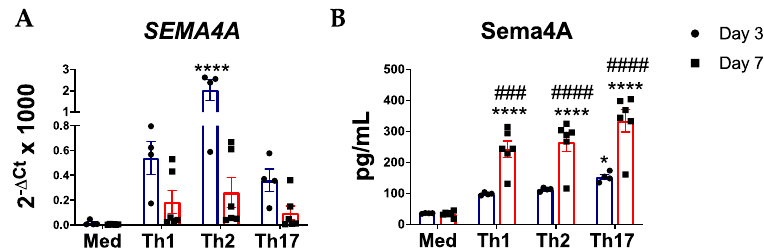
Figure 1. Sema4A is induced during T helper cell differentiation. Sema4A mRNA ( A ) and protein ( B ) levels in unstimulated naïve CD4 + T cells or in Th1, Th2 or Th17 differentiated cells for 3 days ( n = 4) and 7 days ( n = 6). Means and SEM are shown. * p < 0.05 and **** p < 0.0001 compared to the medium at day 3. ### p < 0.001 and #### p < 0.0001 compared to the medium at day